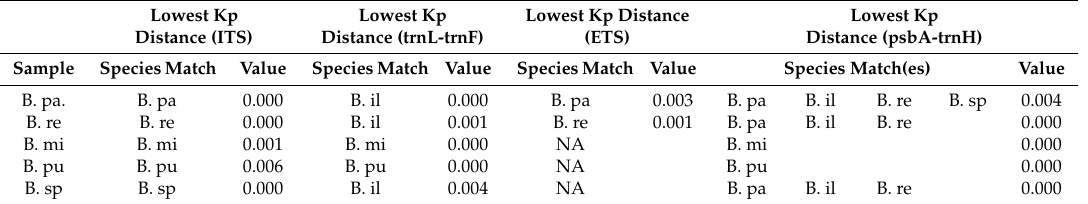
Table 4. KP2 distances between five Baccharis samples and authenticated